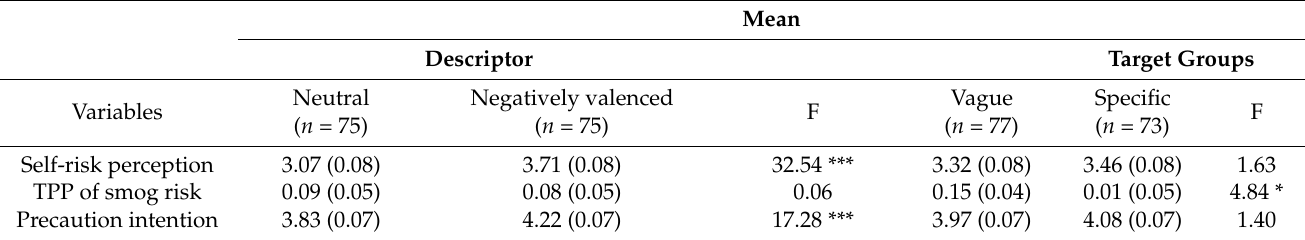
Table 3. Results of two-way ANOVA for the effects of the independent